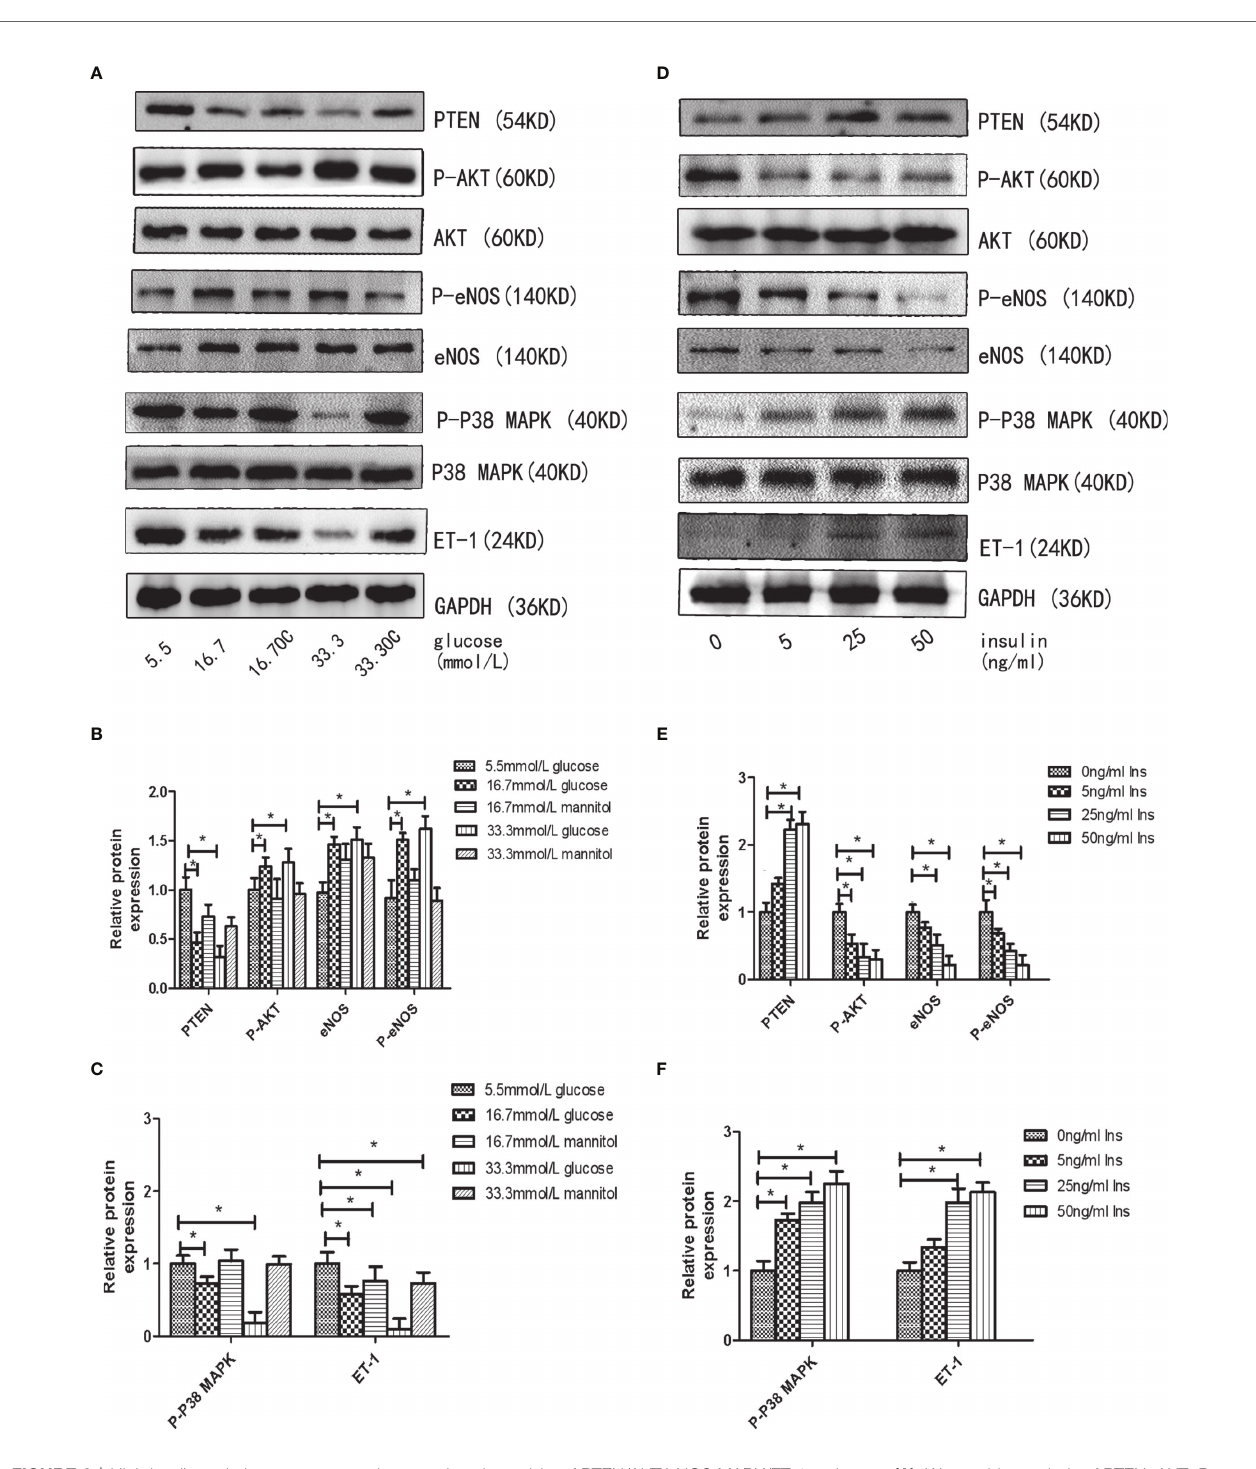
FIGURE 2 | High insulin and glucose concentrations regulate the activity of PTEN/AKT/eNOS MAPK/ET-1 pathways. (A) : Westernblot analysis of PTEN, AKT, P- AKT, eNOS, P38 MAPK, P-P38 MAPK and ET-1 expression in HGECs treatment with different concentrations of glucose and 0ng/ml concentration of insulin for 48h. (B, C) : Quanti fi cation of result in (A). (D) : Westernblot analysis of PTEN, AKT, P-AKT, eNOS, P38, P-P38 and ET-1 expression in HGECs treatment with different concentrations of insulin and 5.5mmol/L concentration of glucose for 48h. (E, F) : Quanti fi cation of result in (D) . Data are reported as mean ± SD *P < 0.05. All data are representative of three independent experiments. OC, osmotic control group; Glu, glucose; Ins, insulin; PTEN, phosphatase and tensin homologue on chromosometen; P-AKT, phospho-AKT; P38-MAPK, p38 mitogen-activated protein kinase; P-P38 MAPK, phospho-p38 mitogen-activated protein kinase; eNOS, endothelial nitric oxide synthase; P-eNOS, phospho-endothelial nitric oxide synthase; ET-1,